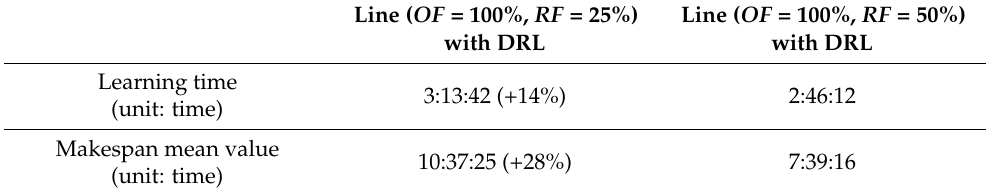
Figure 13. Reward value and makespan comparison according to flexibility. Table 7. Learning time and makespan mean value comparison in Case